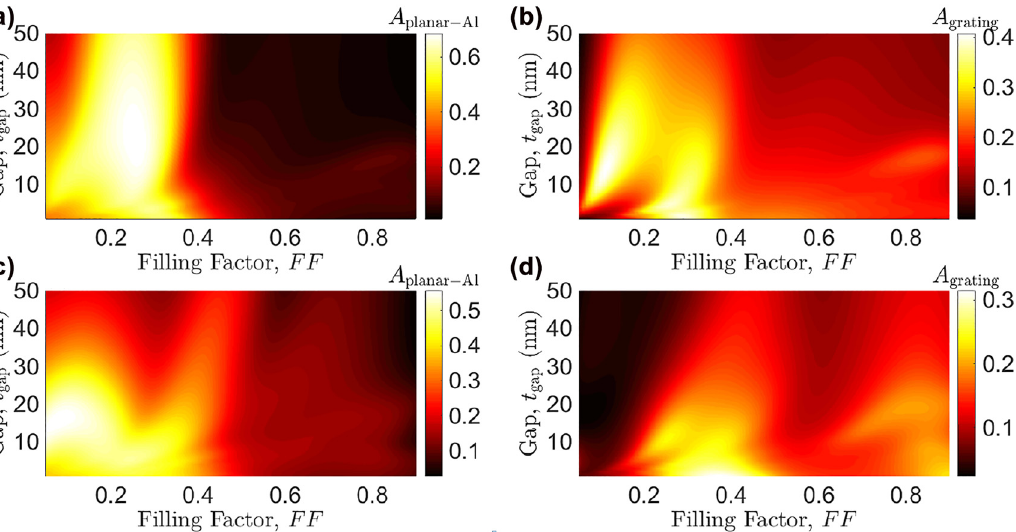
Figure 2: Calculated absorptance dependence of the proposed PD [2D model in Figure 1(c) with only one Al strip] on the filling factor and = 638.9 nm under normal incidence of a TM-polarized plane wave: (a) and (b) are A N gap thickness at 𝜆 Si 3 4 0 nm, respectively, while (c) and (d) are their counterparts for Λ = 850 nm. The thickness of the Al grating, planar Al, TiO is 50, 15, 30, and 50 nm, respectively, while that of the Si substrate is 500 μ m. The total number of space harmonics N t retained in the calculations is 201.